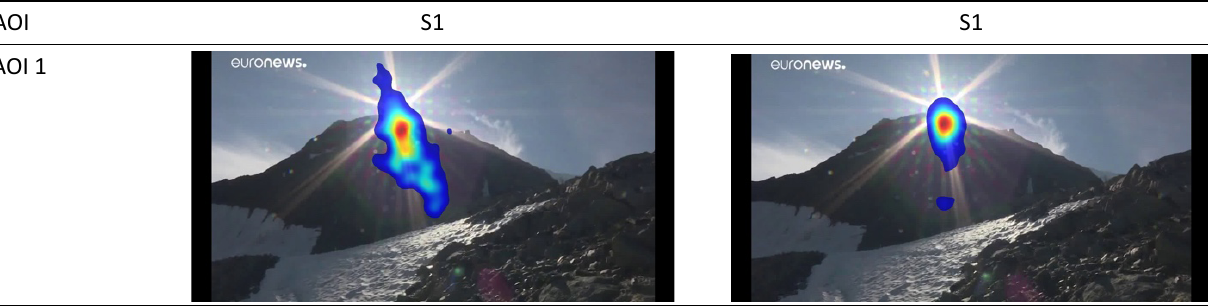
Table 4. Heat maps of the stimuli. AOI S1 S1 AOI 1